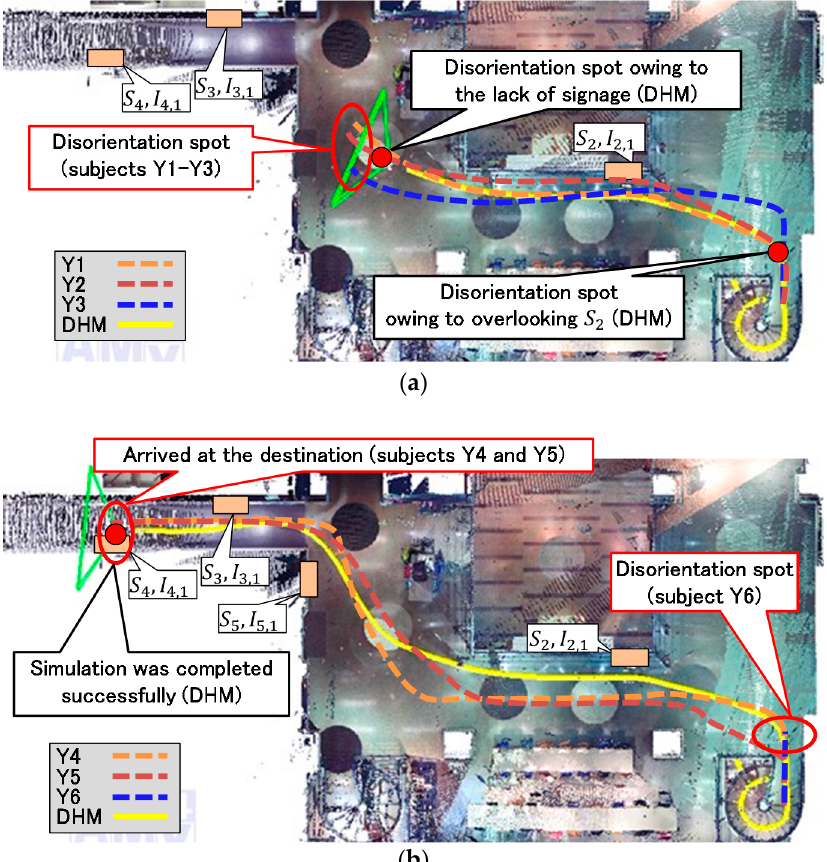
Figure 14. Comparison of wayfinding results between simulation and human measurements: ( a ) Comparison using S = { S 1 , S 2 , S 3 , S 4 } ; ( b ) comparison using S ∪ S 5 .